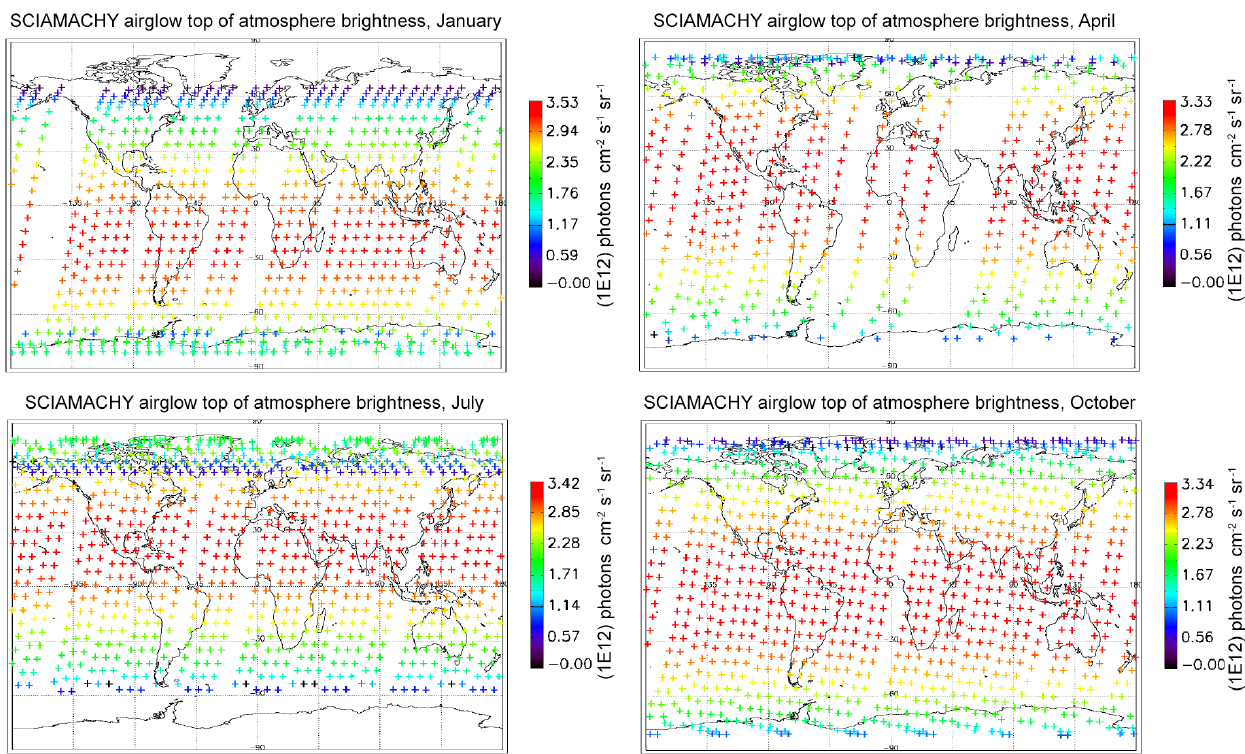
Figure 7. Airglow brightness maps as seen from space in nadir view, retrieved from SCIAMACHY limb-viewing data for the months of January, April, July, and October 2007 (first 3d of each month only). The colour scale represents brightness. Zones without data (holes), particularly numerous in April, are corrupted products that have been eliminated. SZA points > 90 ◦ have been